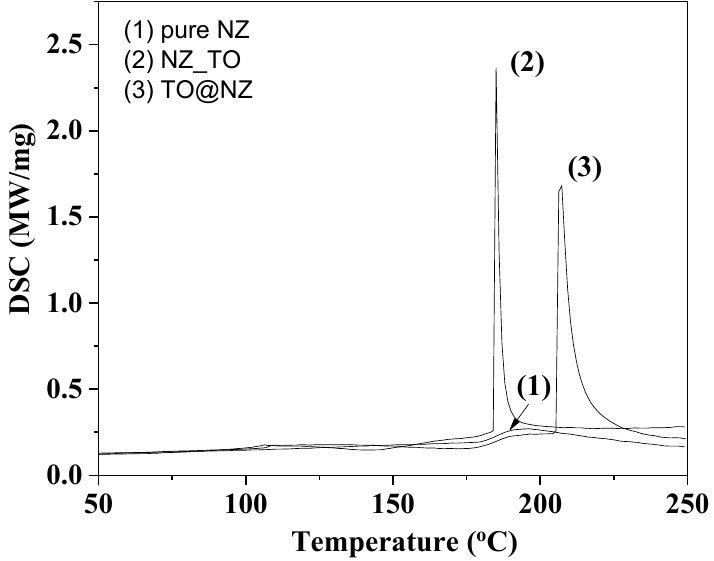
Figure 1. DSC plots of (1) pure NZ, (2) TO_NZ hybrid nanostructure and (3) TO@NZ hybrid nanostructure.